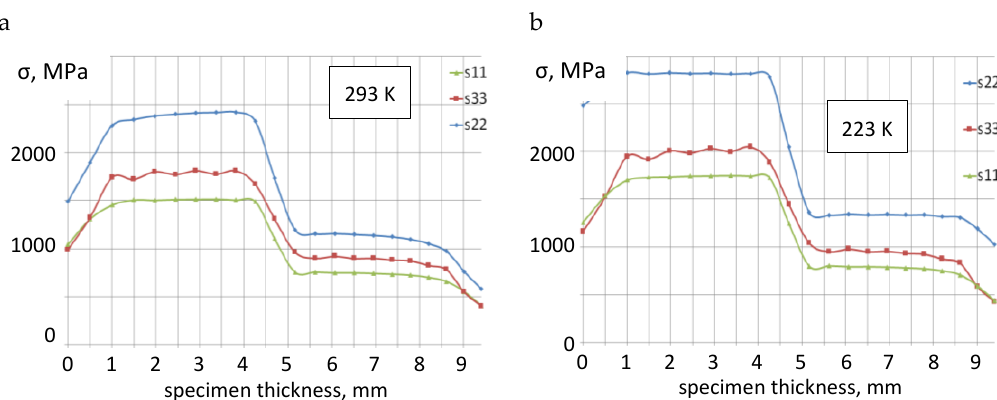
Figure 6. Stress distributions in front of the crack tip: ( a ) for ambient temperature, 293 K and ( b ) for reduced temperature, 223 K.